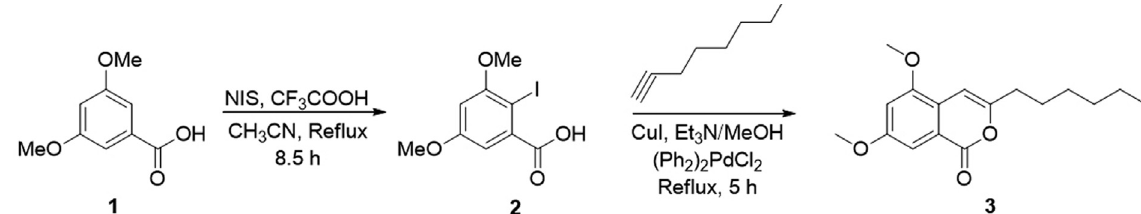
Figure 1 - Synthesis of new isocoumarin (3) from precursor compounds 1 and